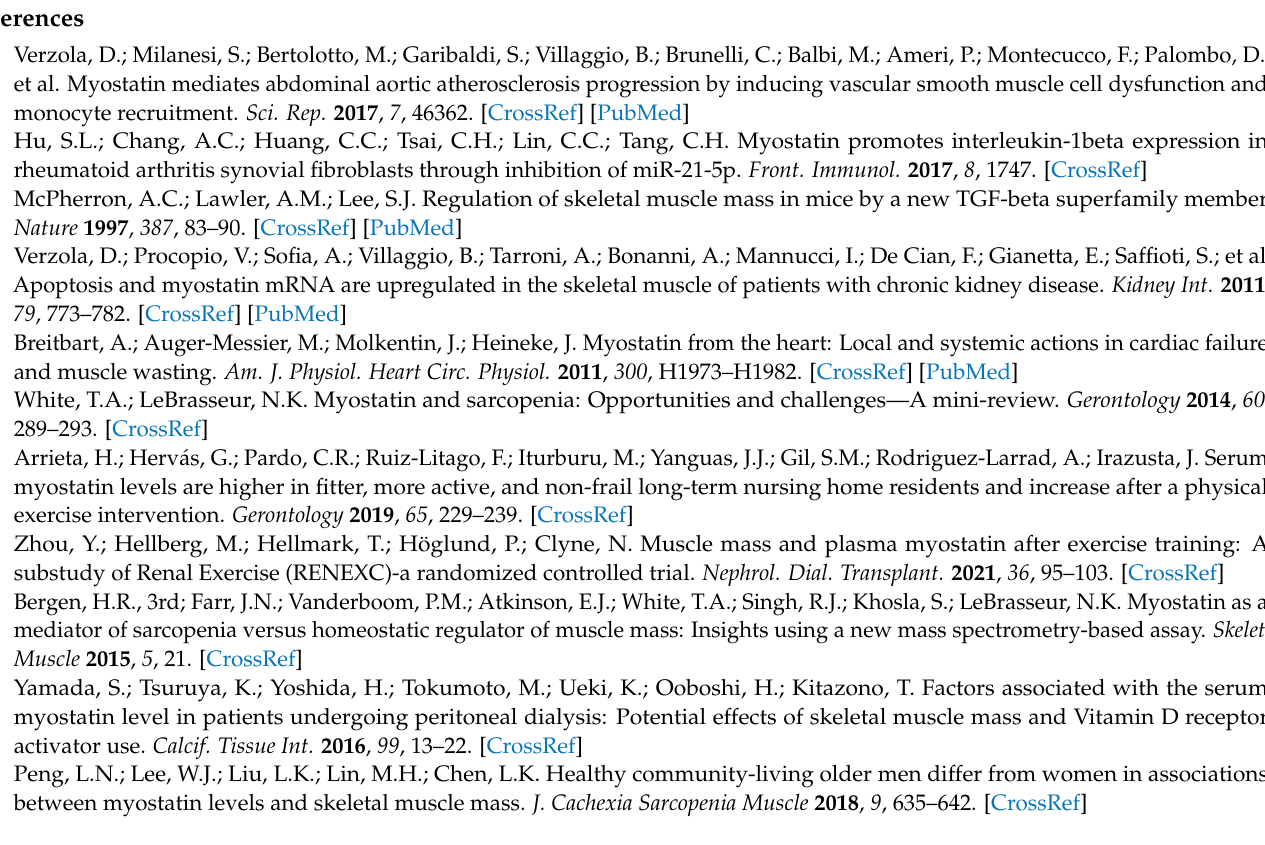
Figure S2: Comparison of proportions (%) with sarcopenia and severe sarcopenia by Asian Working Group for Sarcopenia 2019 and chronic kidney disease (CKD) according to serum myostatin